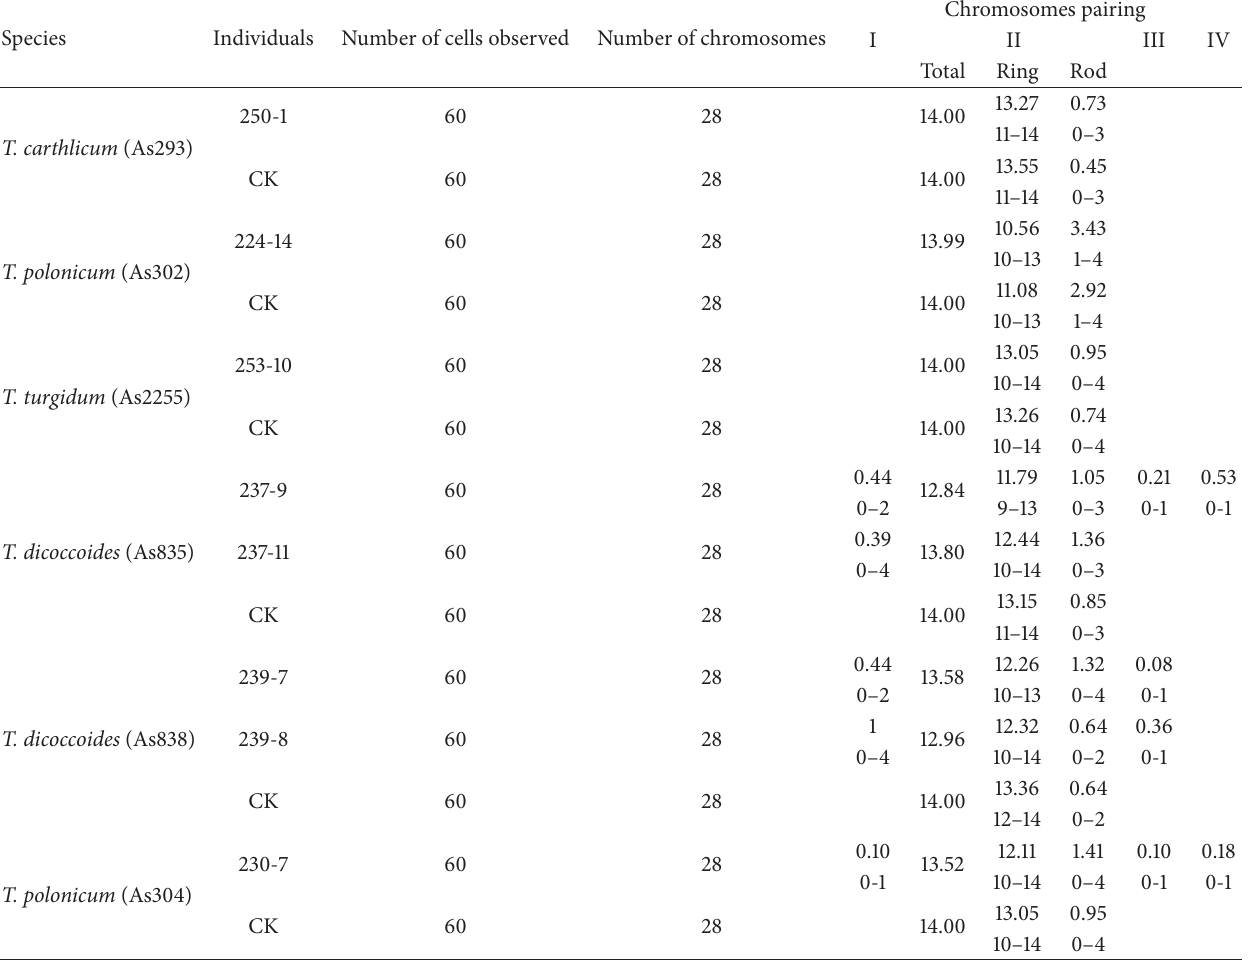
Table 4: Chromosome pairing at metaphase I in the pollen mother cells of the materials with special traits after radiation treatment.